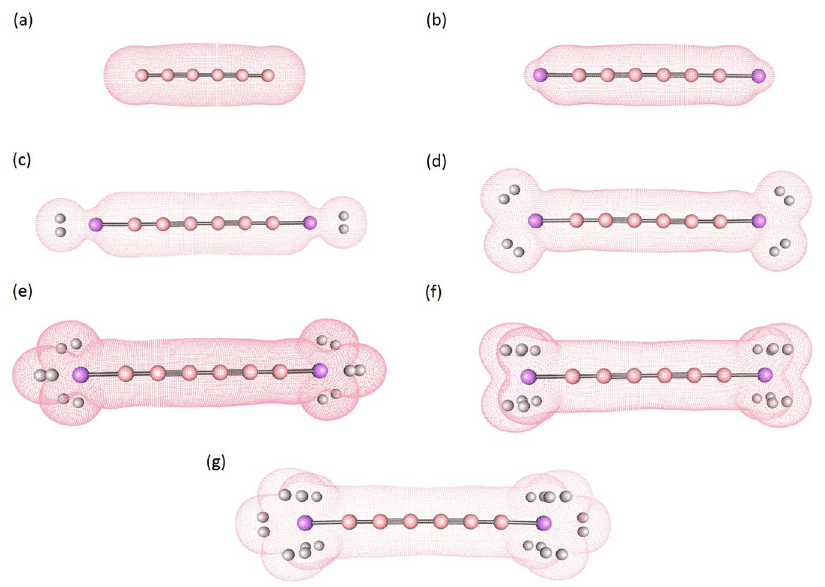
Figure 10. Isosurfaces of charge density (the isovalue is 0.02 e/Å 3 ) for ( a ) B 6 and ( b – g ) Li 2 B 6 with x H 2 molecules ( x = 0–5) adsorbed on each Li, obtained with TAO-BLYP-D. Here, pink, purple, and white balls represent B, Li, and H atoms,